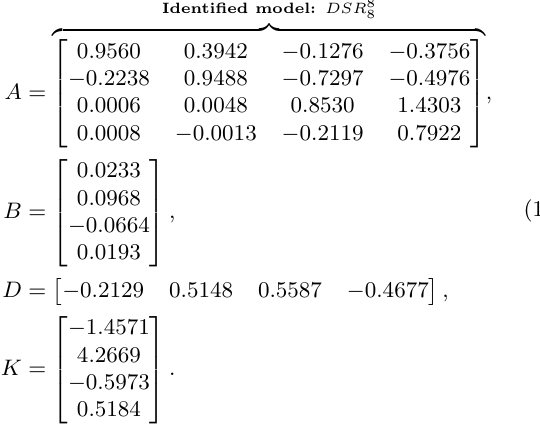
Table 3: Comparing models identified from dsr and pem.